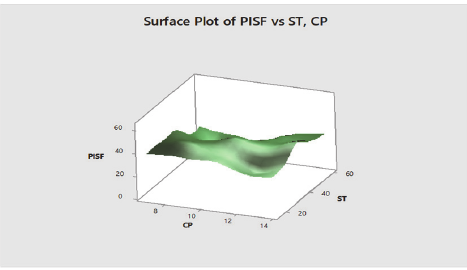
Fig. 3. Surface plot between for PISF vs CP, ST Fig. 4. Normal probability plot of the